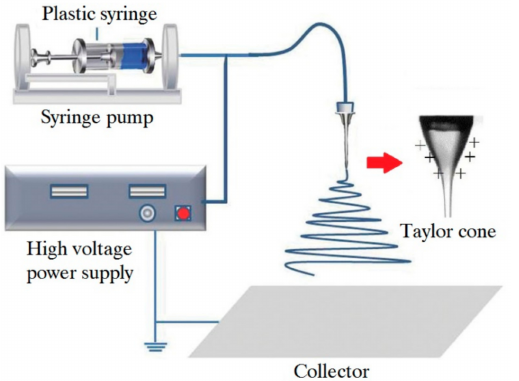
Figure 1. Schematic drawing of elementary setup for electrospinning.